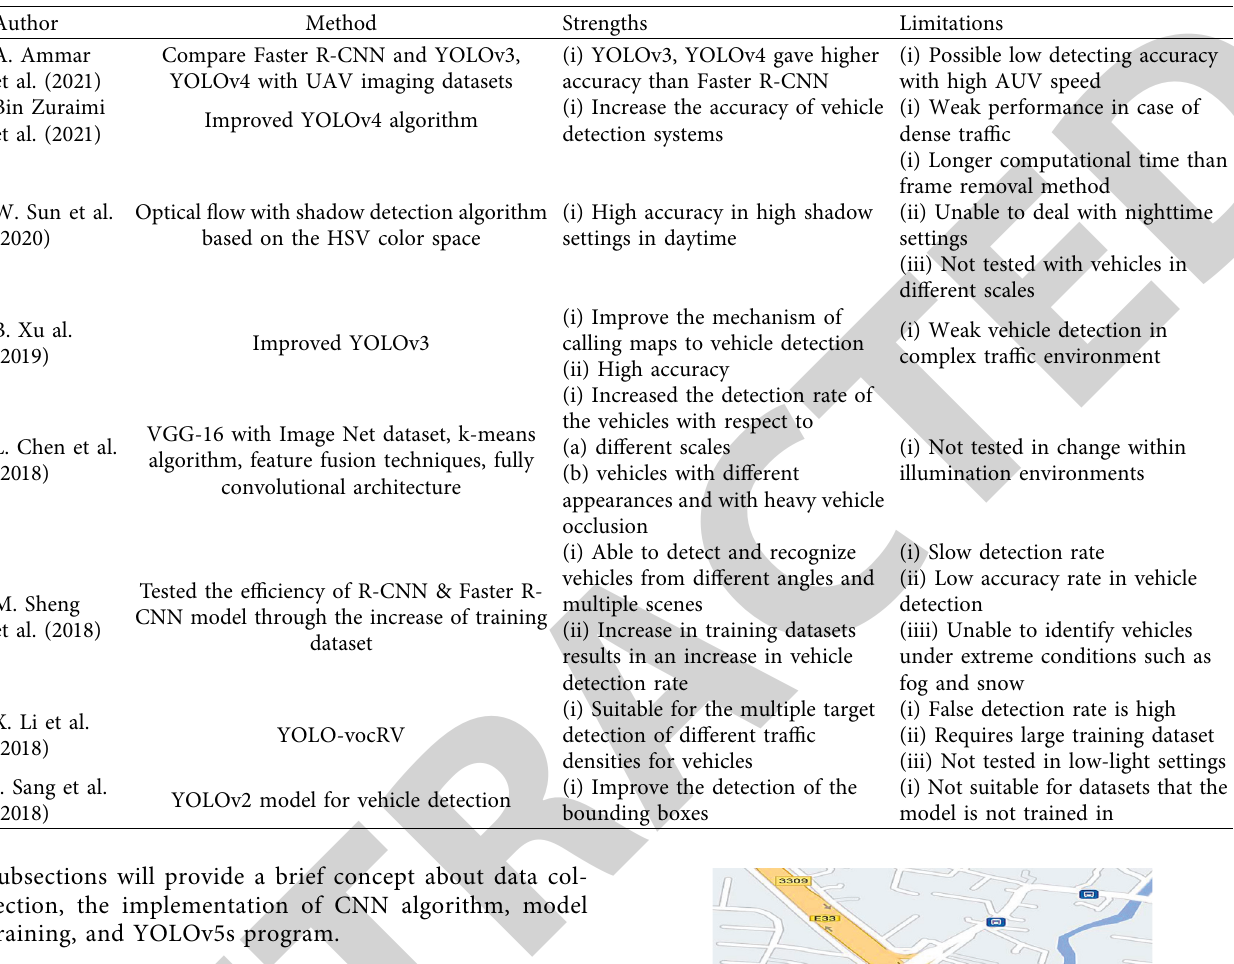
Table 1: Summary of related research.